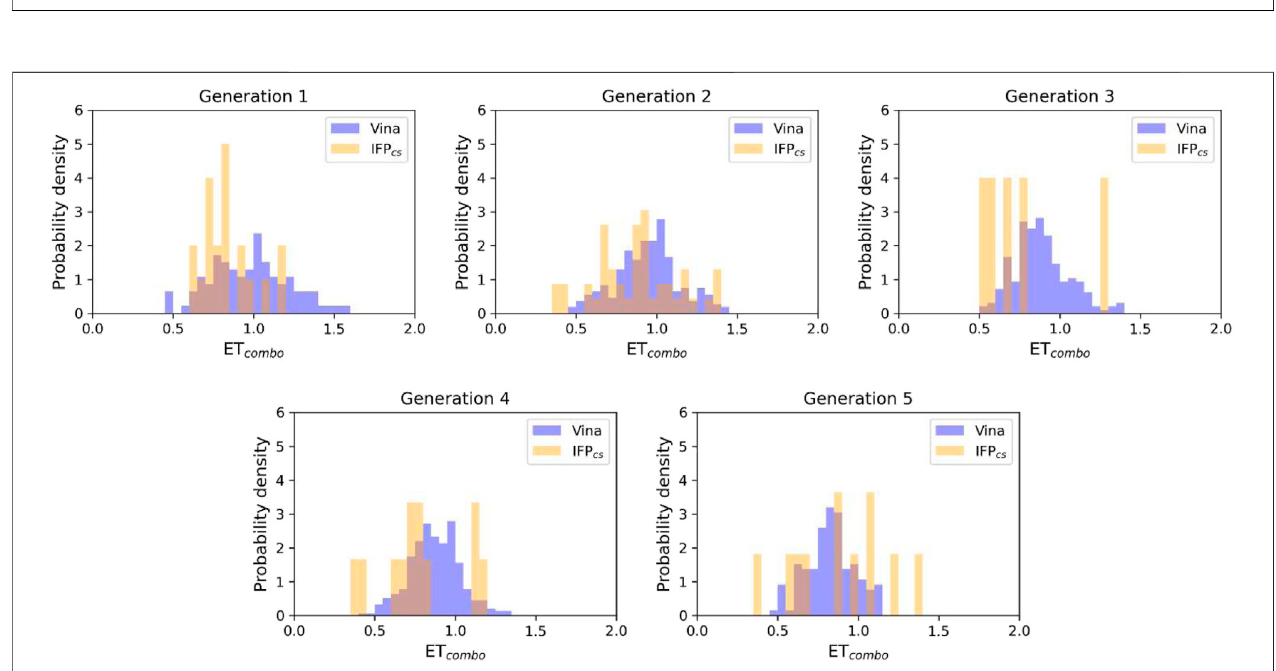
FIGURE 9 | The ability of the two Autogrow protocols in the benchmark lead-optimization run to produce compounds that have a high degree of similarity with regard to shape and electrostatic properties to the crystallographic ligands, chosen as reference. The probability distribution of the ET combo score for compounds populating each generation is reported as a histogram, where the vertical axis reports the probability density while the horizontal axis reports the ET combo value. Two distributions are reported within each plot: the blue bars refer to compounds generated with the VINA protocol, while the orange bars refer to compounds generated with the IFP CS